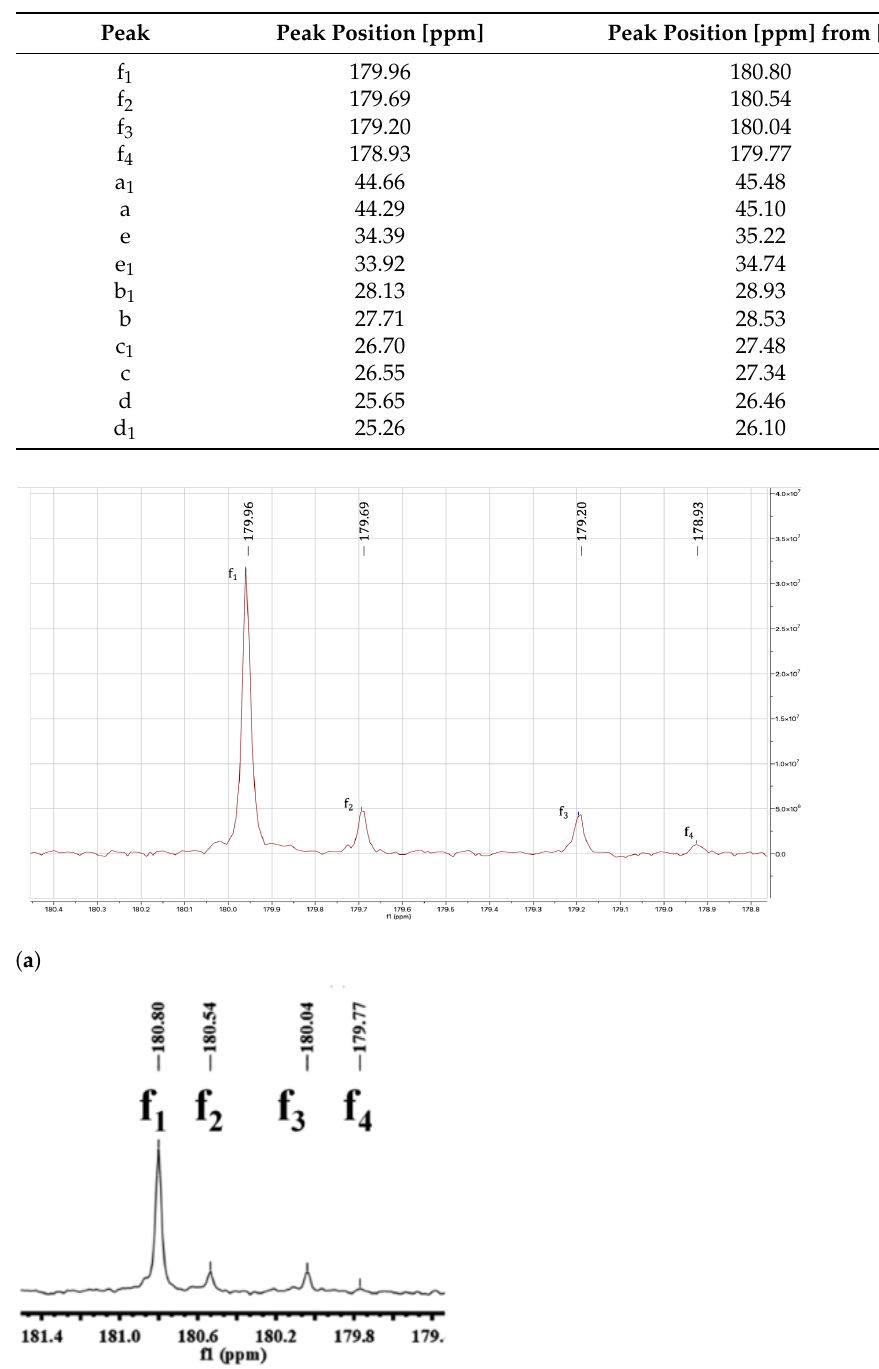
Figure A2. A comparison between the characteristic peaks of the carbonyl groups f 1 to f 4 of ( a ) the qualitative 13 C-NMR spectrum of the employed HMWPA copolymer and ( b ) the quantitative 13 C- NMR spectrum for a random PA 6/66 copolymer with a PA 66 molar comonomer fraction of 15% as obtained by Tang et al. (2018)